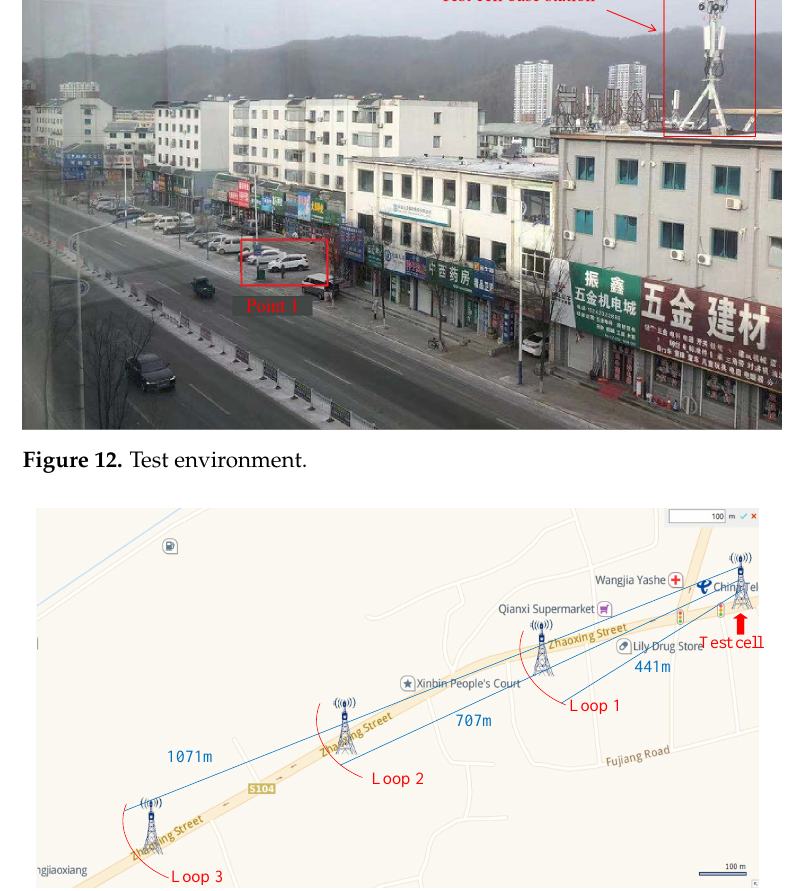
Figure 13. Test environment networking